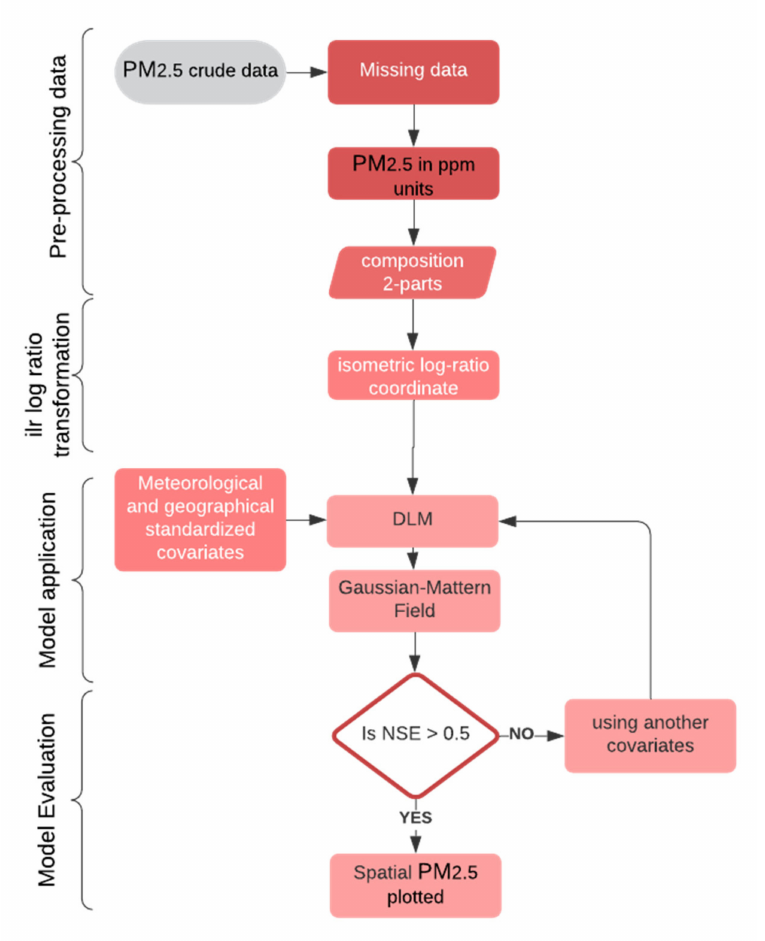
Figure 2. Algorithm of spatio-temporal PM 2.5 model in wildfire events using